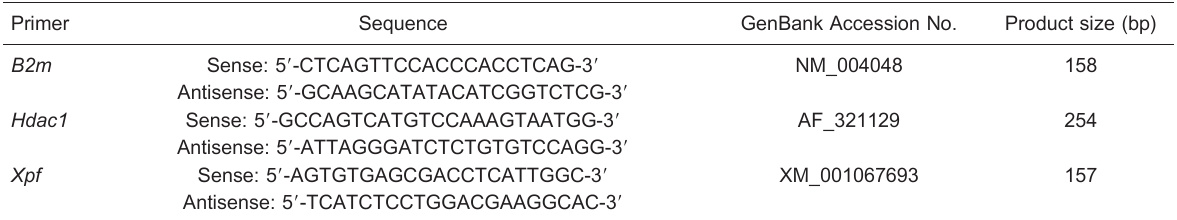
B2m and Hdac1 are housekeeping